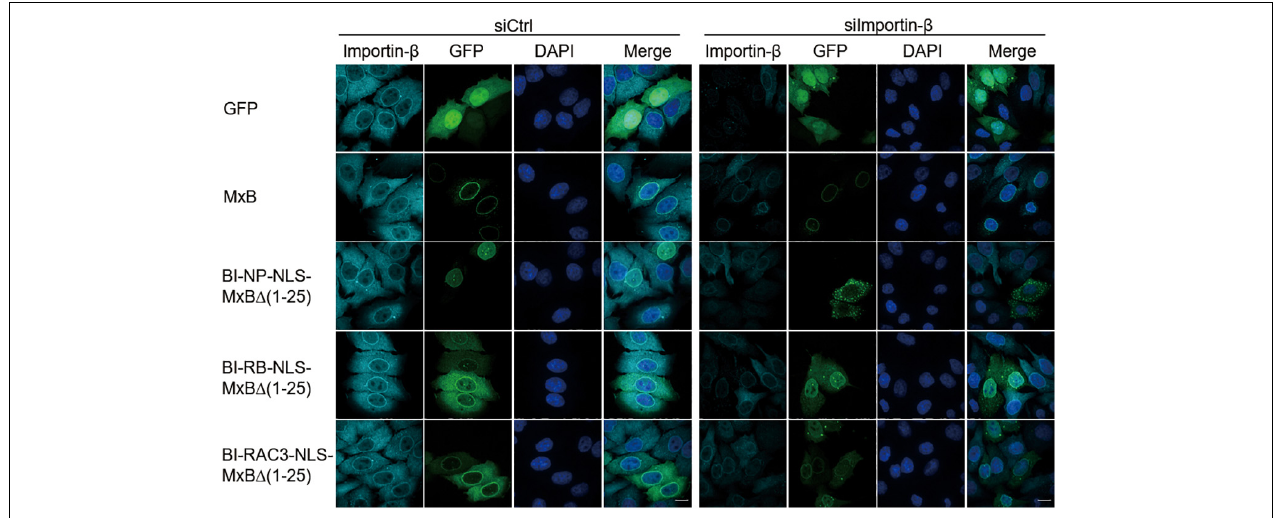
FIGURE 2 | Nuclear localization of BI-NP-NLS-MxB (cid:49) (1–25) depends on importin- β . MxB or MxB mutants bearing a C-terminal GFP tag were expressed in HeLa cells that were transfected with control siRNA (siCtrl) or siRNA targeting importin- β (siImportin- β ). Endogenous importin- β was immuno-stained with anti-importin- β antibodies. The subcellular localization of MxB and importin- β was visualized by confocal laser scanning microscopy. Scale bars represent 10 µ m.